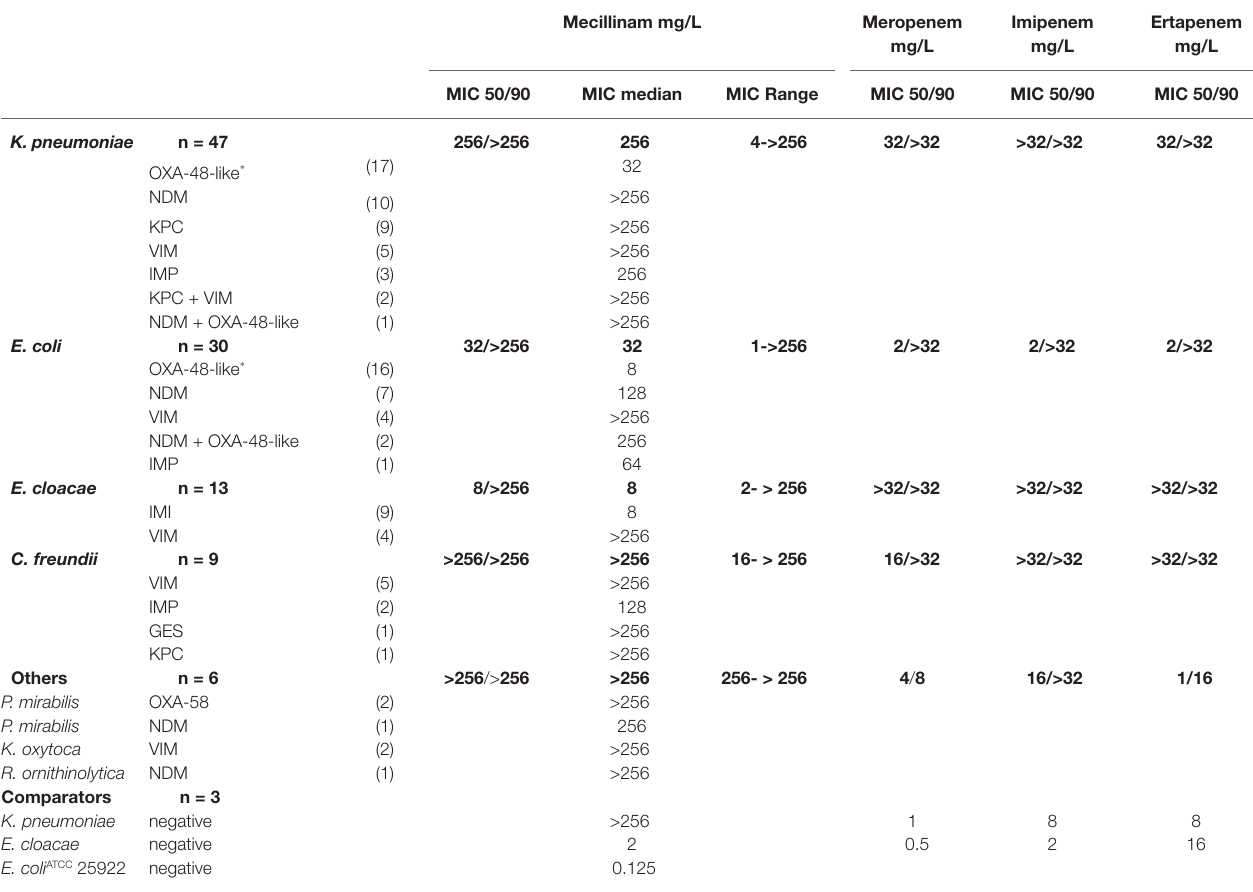
TABLE 1 | MICs for mecillinam and carbapenems of all isolates displayed by species and